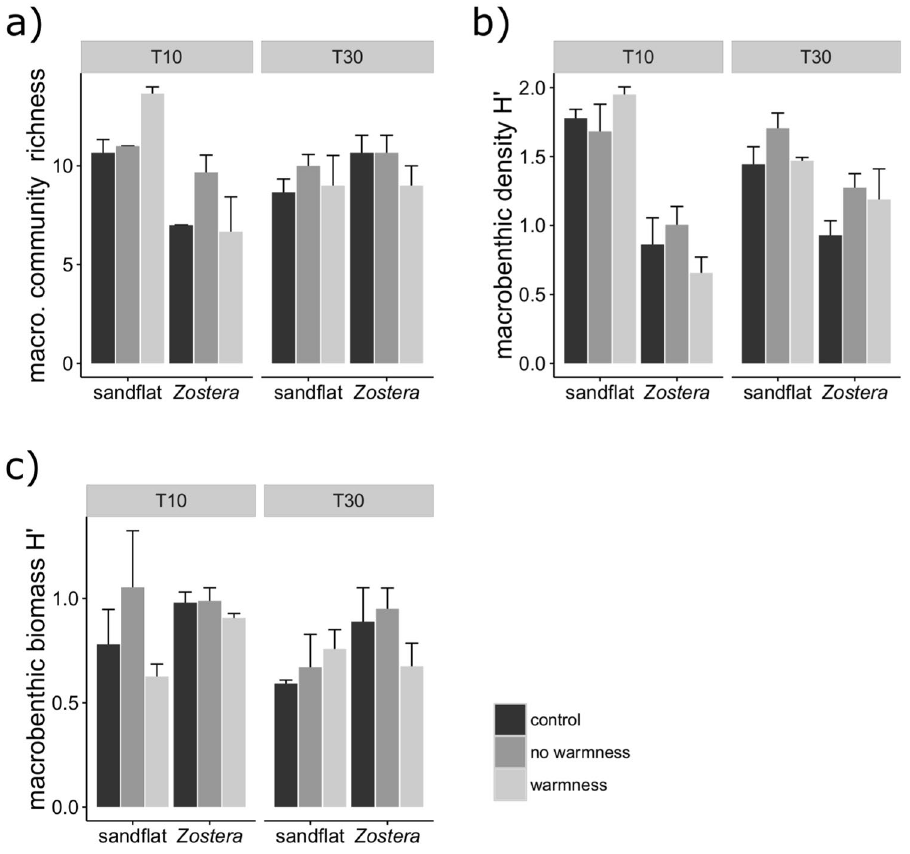
Figure 1. Mean + s.d. (n = 3) species richness ( a ) and Shannon-Wiener index of the macrobenthic communities measured with density ( b ) and biomass ( c ) in the sandflat and Zostera areas, under control, no warmness and warmness treatment, for the two time